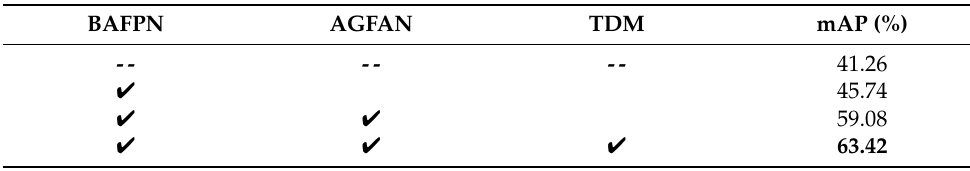
Table 4. Effectiveness of each improvement in RBFA-Net.